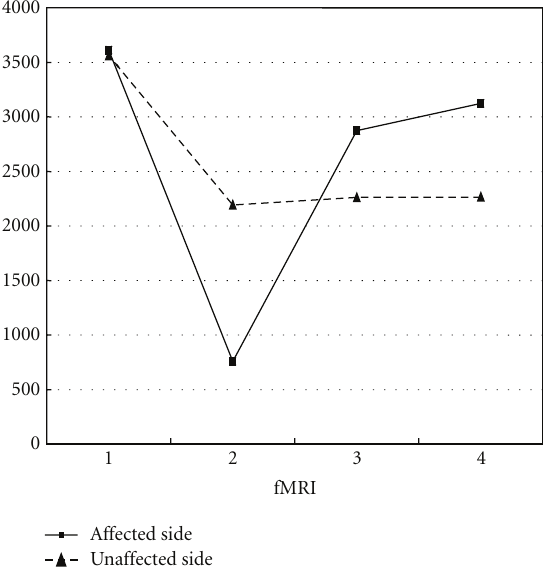
Figure 4: A transition of the number of activated voxels in the con- tralateral SMC of three patients with good